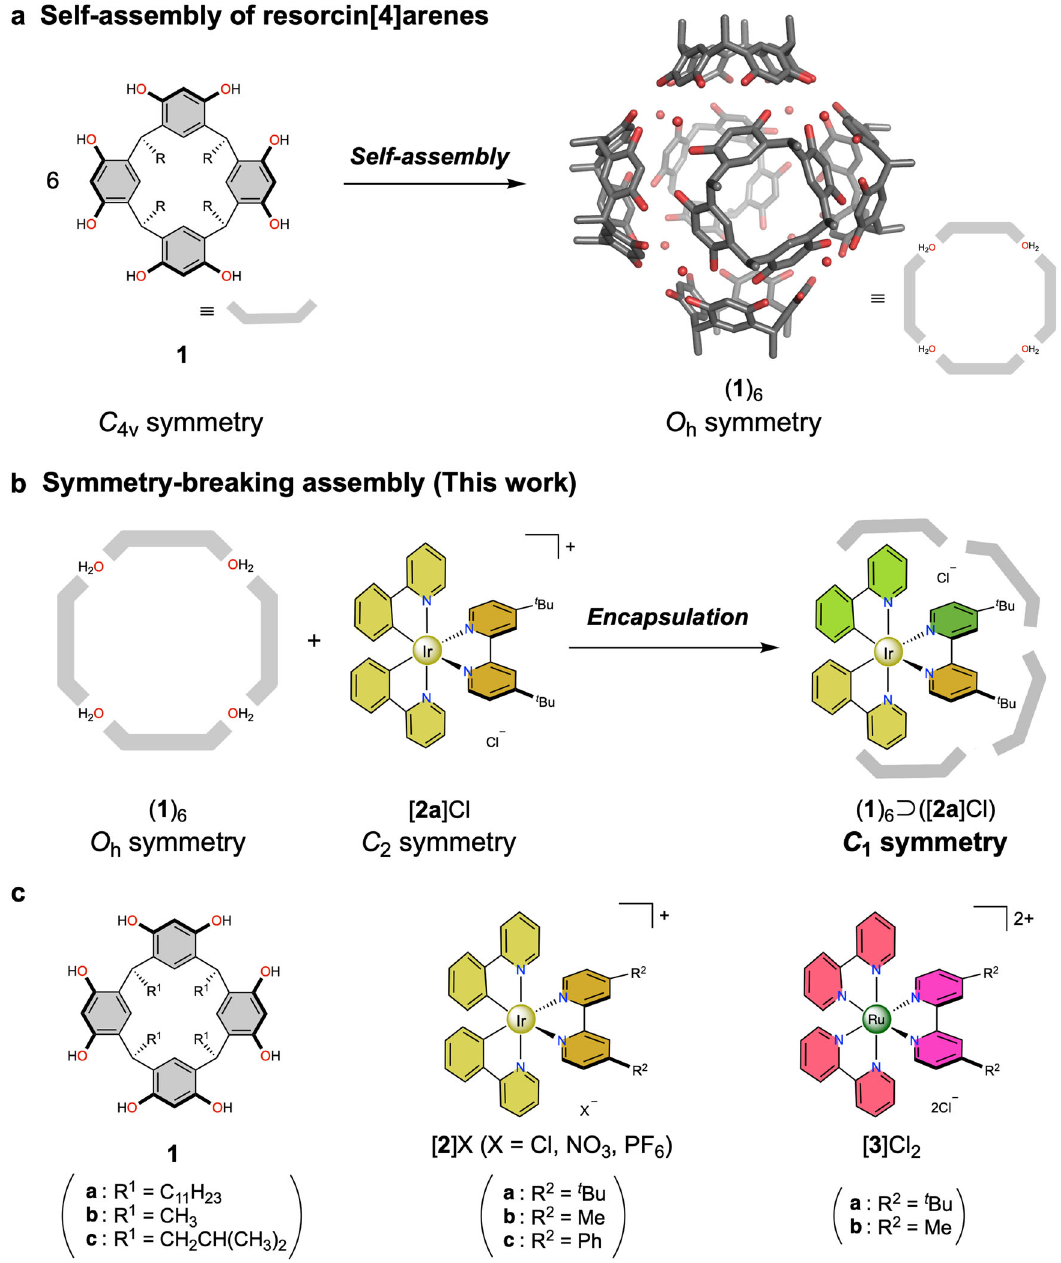
Fig. 1 | Self-assemblyofhydrogen-bonding resorcin[4]arenehost.a Formation of a hexameric capsule with eight water molecules. b Symmetry-breaking assembly via host – guest complexation. c Compounds used in this